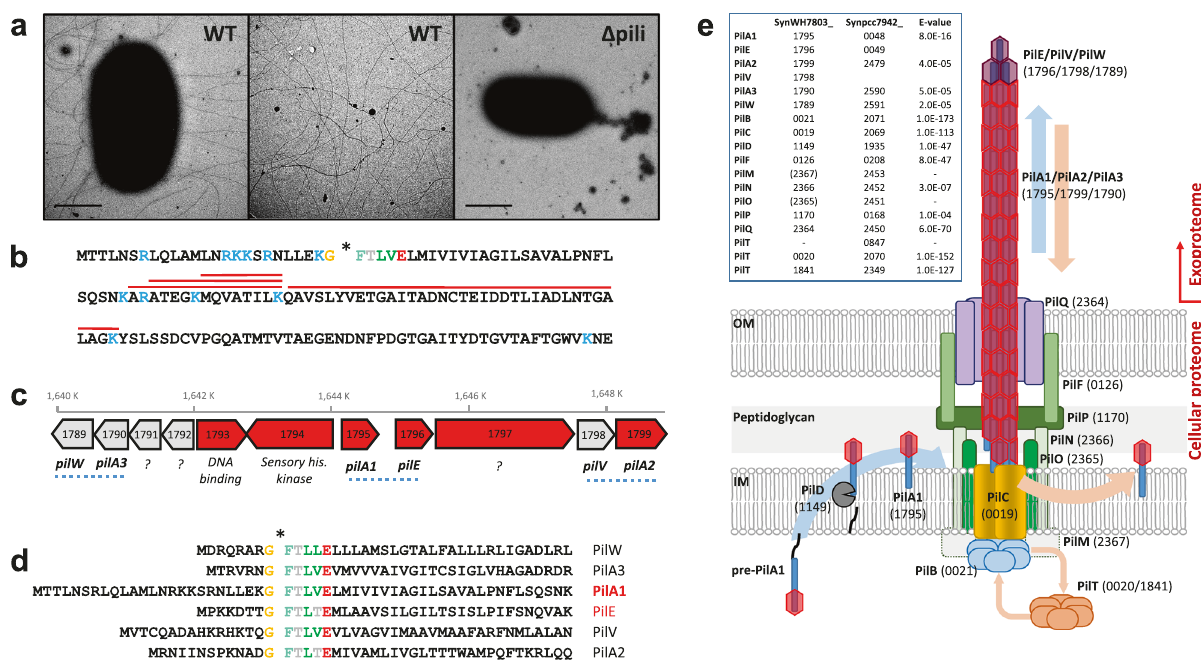
Fig. 1 Pilus in the marine cyanobacterium Synechococcus sp. WH7803. a Transmission electron microscopy images of wild-type Synechococcus sp. WH7803 (WT) and pili mutant ( Δ pili) obtained from late-exponential liquid cultures incubated in ASW medium under optimal growth conditions. Imaging of three independent cultures in different occasions consistently showed long pili appendages only in the wild-type strain (Fig. S1). Middle panel image, obtained with the same magni fi cation as other panels, is from an intercellular region between wild-type cells to improve the visualisation of the pili. Scale bar represents 1 µ m. b The amino acid sequence of PilA1 (SynWH7803_1795). Trypsin hydrolytic sites are indicated in blue. Red lines highlight tryptic peptides detected by shotgun proteomics. The conserved GFTLxE motif is shown and the cleavage site is indicated with an asterisk. c Genomic context of pilA1 in Synechococcus sp. WH7803. Numbers in each gene represent their ID number (SynWH7803_). In red are genes detected by proteomics. While PilA1 and PilE are abundantly detected in exoproteomes 20 , PilA2 has only ever been detected in cellular proteomes of this strain 22 . Blue dotted lines indicate genes encoding possible structural pilin pairs, i.e. PilA1-PilE, PilA2-PilV and PilA3-PilW. Question marks indicate genes encoding proteins of unknown function. d The N-terminal amino acid sequence of PilA1 and fi ve other pilin-like proteins, all with the highly conserved GFTLxE motif. e Synechococcus sp. WH7803 structural pilus proteins identi fi ed by homology with S. elongatus PCC 7942 16 and assembled in the inner (IM) and outer membrane (OM) as modelled by Craig et al 11 . pilM and pilO were not identi fi ed by homology but the SynWH7803_2367 and SynWH7803_2365 genes are suggested because they form a standard pilMNOQ operon as found in other species. While S. elongatus PCC 7942 encodes three pilT , only two were found in Synechococcus sp. WH7803, one being part of the characteristic pilCTB